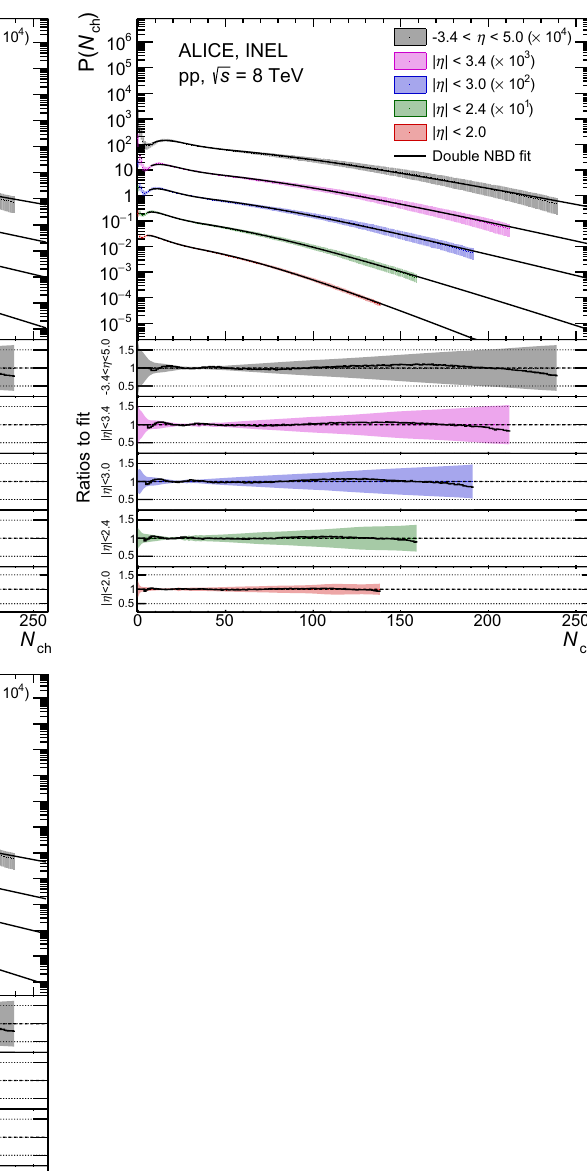
contributions from hard and soft processes, the distributions are fitted with double Negative Binomial Distributions. The results are also compared with the LHC measurements done by CMS and with distributions obtained from models includ- ing the IP-Glasma, which is based on the Color Glass Con- densate (CGC)